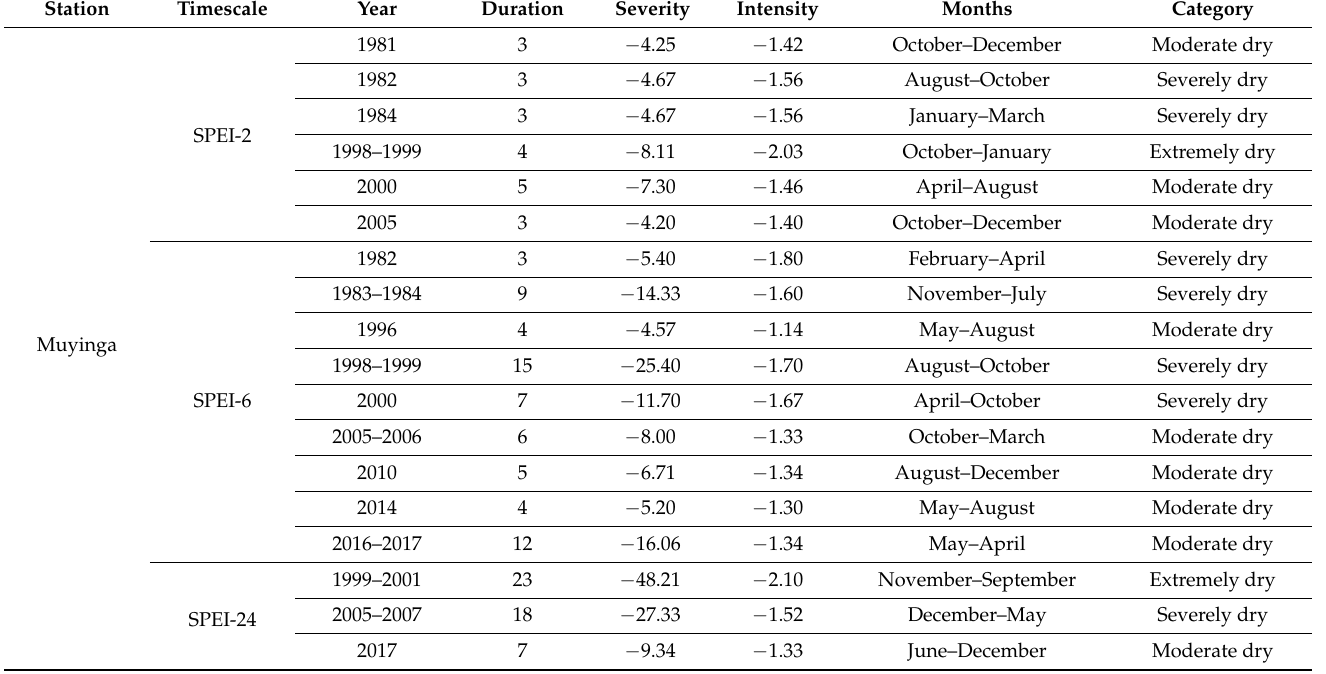
Table 3. The longest drought incidents recorded and their categories of dryness based on the intensity during the study period for each meteorological